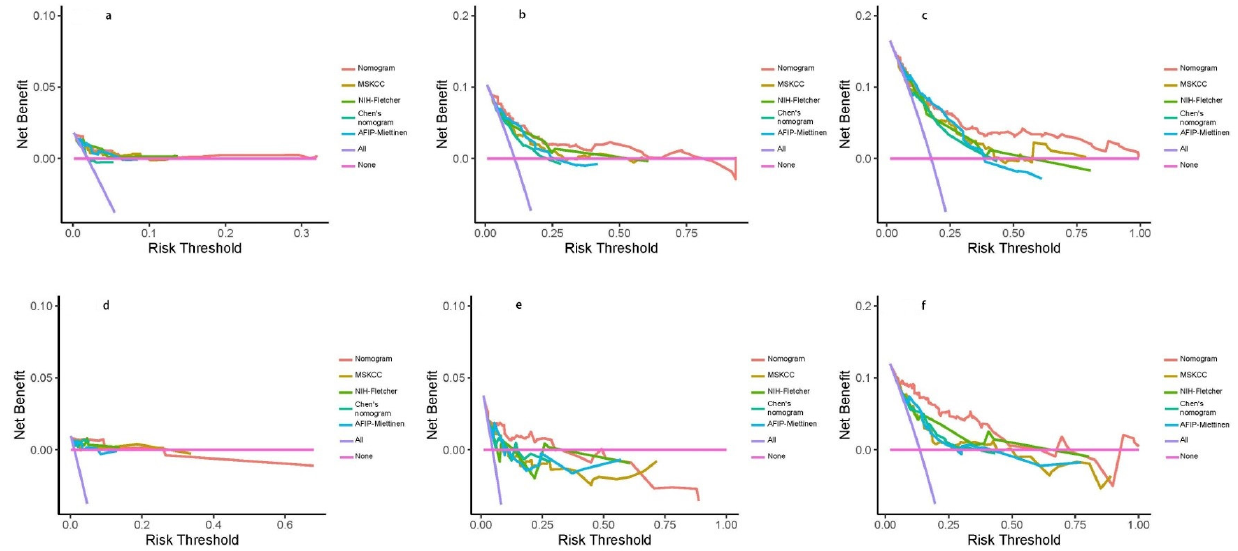
Figure 5. The DCA for each prognostic scoring system. ( a ) The 1-year DCA curves in the training set. ( b ) The 3-year DCA curves in the training set. ( c ) The 5-year DCA curves in the training set. ( d ) The 1-year DCA curves in the validation set. ( e ) The 3-year DCA curves in the validation set. ( f ) The 5-year DCA curves in the validation set.